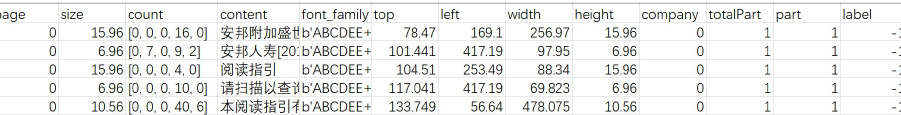
Figure A2. The file format in the data pre-processing step (in Chinese). We modify the Pdfplumber algorithm framework for PDF document information conversion, which can get more features in documents content. The features mainly include size, font family, top, and company etc. The features named top, left, width, and height mean the context relative location information.